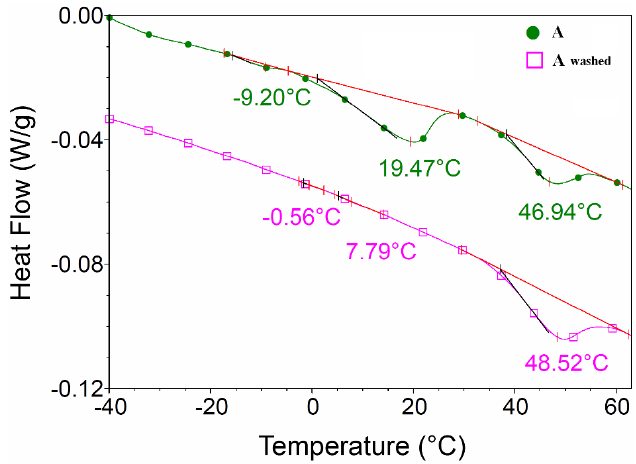
Figure 8. Differential scanning calorimetry (DSC) analysis of sample A (as synthesized and washed with ammonium hydroxide).